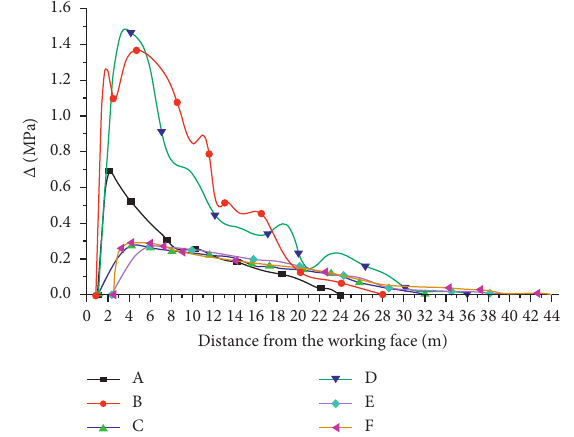
Figure 7: The variation of stress with distance at different mea- suring points ( Δ P-L) graph. A: 2 m, B: 4.44m, C: 6.44m, D: 8.44m, E: 10.94m, and F: